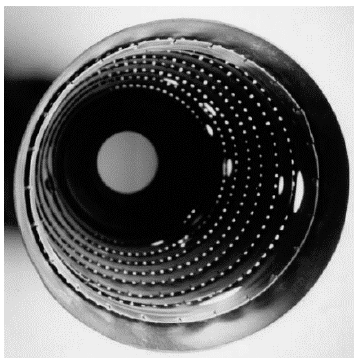
Figure 1. The inner surface of the combustion chamber showing the film cooling holes [5].